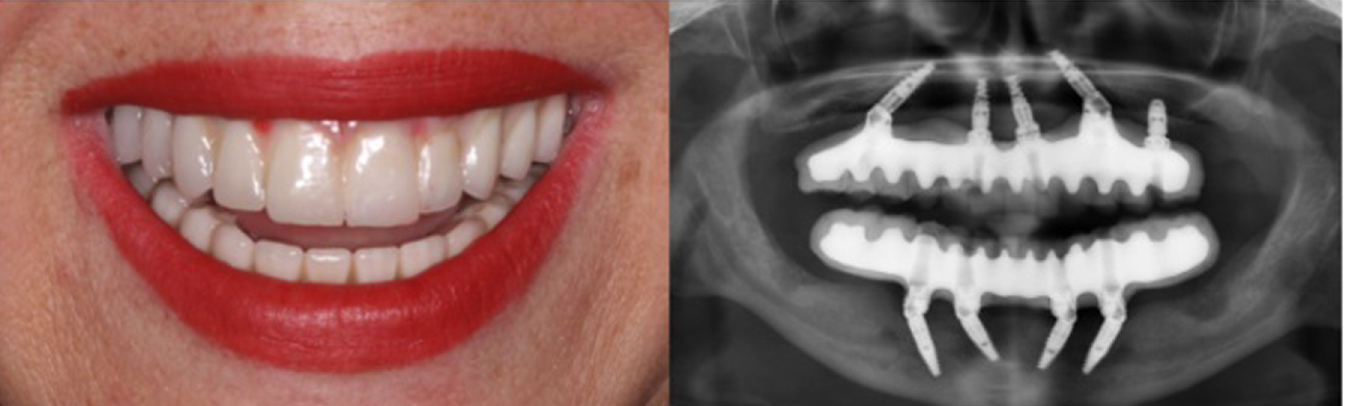
PLOS ONE | https://doi.org/10.1371/journal.pone.0284319 April 14,